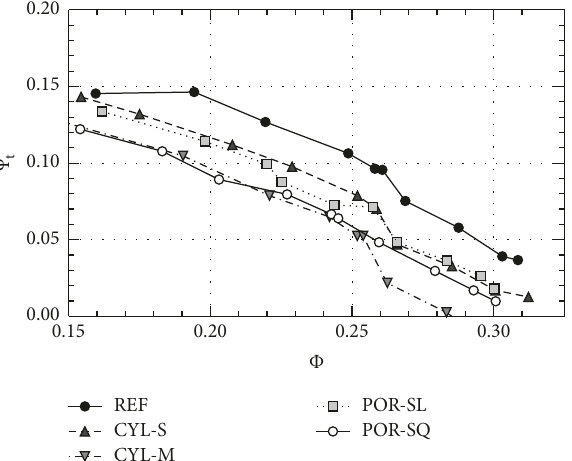
Figure 16: Influence of different cylindrical shroud extensions under 𝜇 = 0.245 and 𝛾 = 90 ∘ .